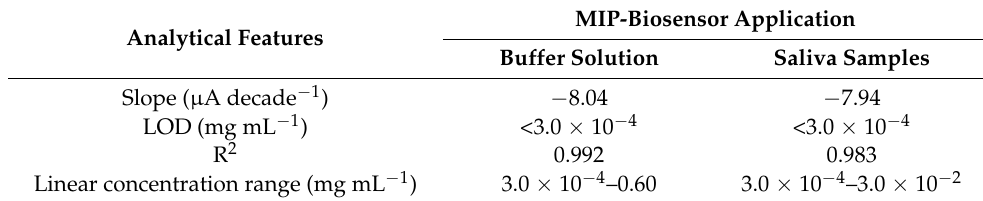
Table 1. Comparison of the analytical features resulting from calibration curves obtained in buffer solution and human saliva